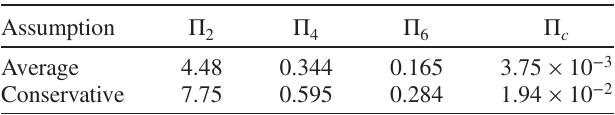
TABLE III. Nondimensional parameters obtained from Tables I and II. The first and second rows correspond to different energy deposition width considerations, namely one that uses a geo- metric average and one that uses the minimum width of the 3D Gaussian distribution fit.